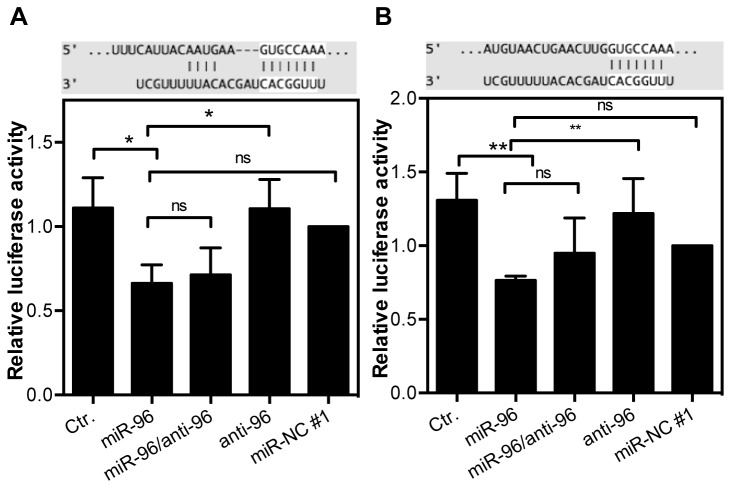
Binding of miR-96 in the 3’ UTR of FOXO1.LNCaP cells were transfected with 10 nM pre-miR-96, anti-miR-96, pre-miR-NC #1 or combination of pre-miR-96 and anti-miR-96 as well as 500 ng pMiR report β-Galactosidase control plasmid and 500 ng pMiR report plasmid for FOXO1 3’ UTR A) binding site 1 at position 264-270 and B) binding site 2 at position 2138-2145. * P <0.05, **P <0.01, One-way ANOVA and Tukey’s multiple comparison post test.